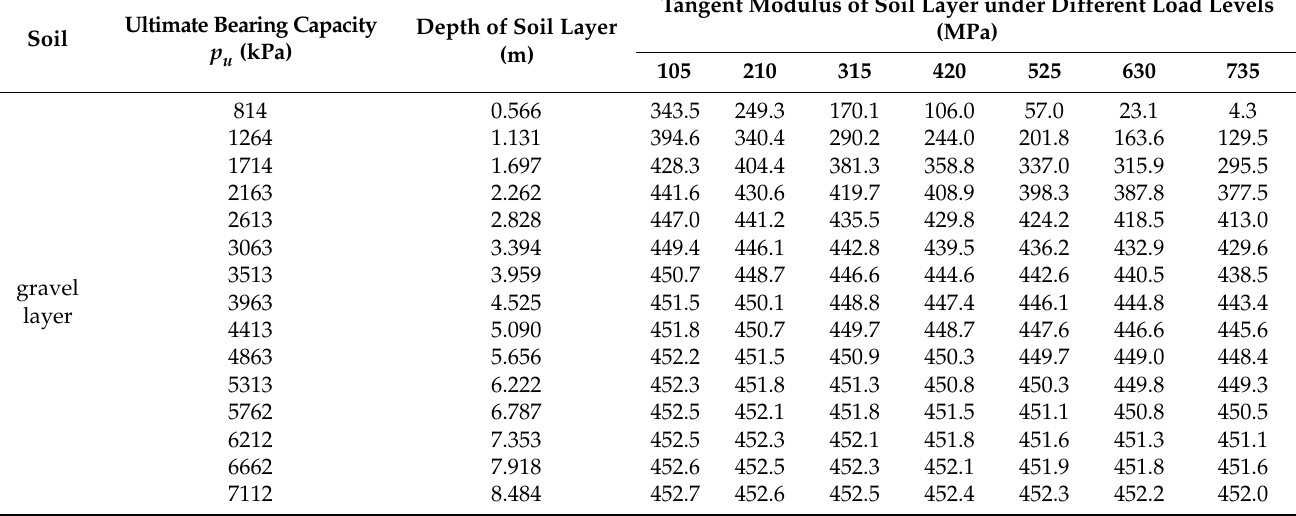
Table 4. Calculation of tangent modulus of gravel layer under various loads.